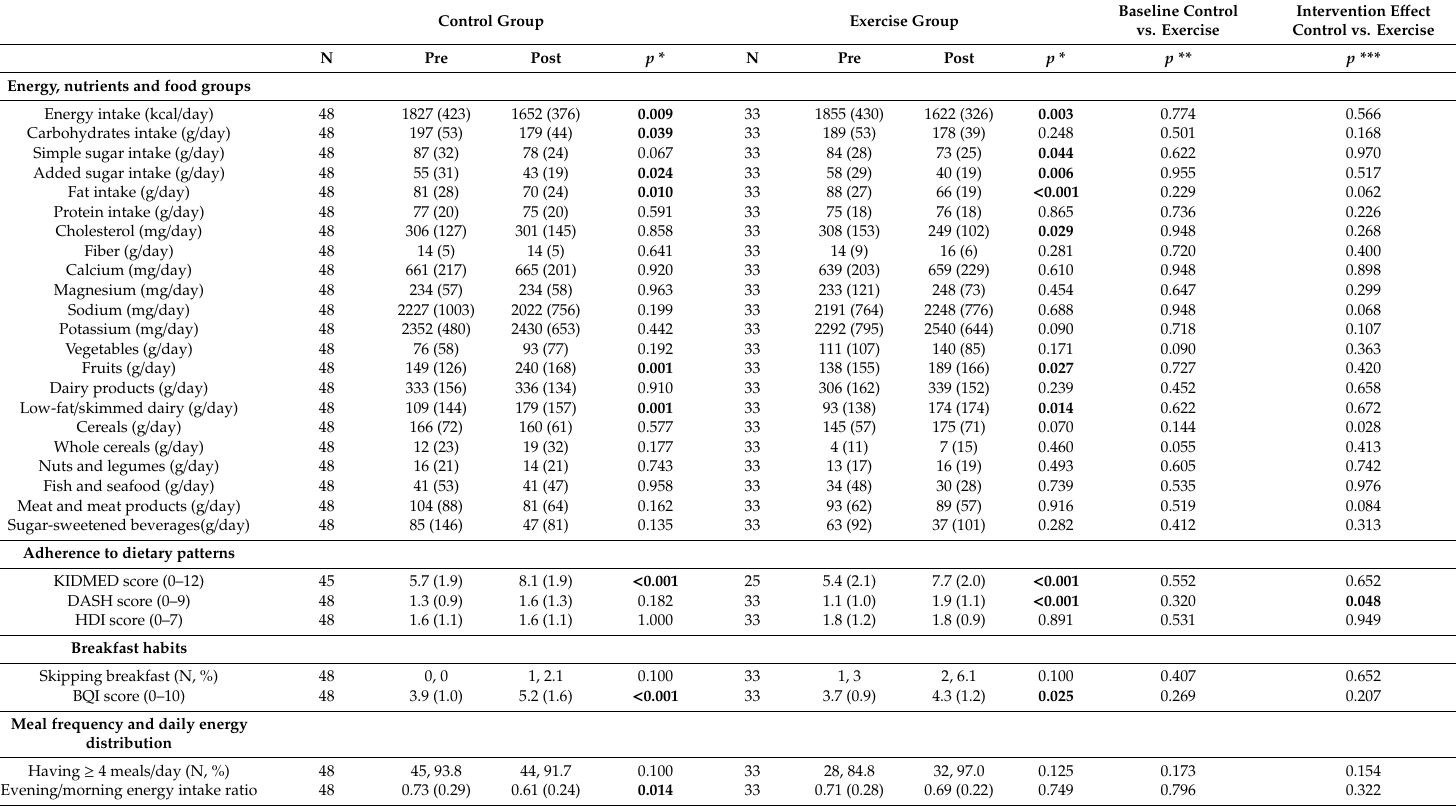
Table 2. Dietary habits of children participating in the family-based lifestyle program (control group) and in the same plus exercise program (exercise group), before (Pre) and after (Post) the